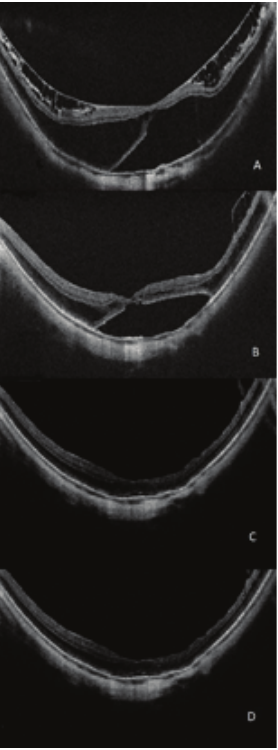
Figure 1. Intraoperative snapshot showing fs-ILM peeling using 3-D surgical viewing.